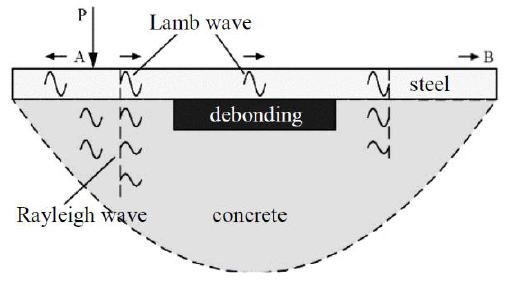
Figure 1. The surface wave propagation in CFSTs.